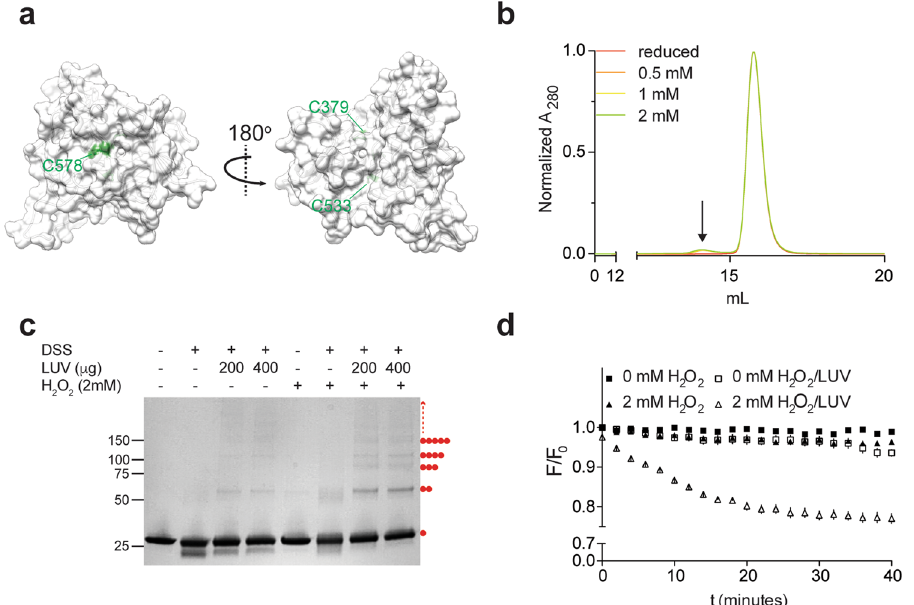
Figure 7. mCLIC6 oligomerization and membrane association. ( a ) Cysteine exposure (green), demonstrated using surface representation of mCLIC6 structure (grey). Note the C533 is inaccessible to the external solution. ( b ) Analytical size exclusion chromatography in the presence of increasing H 2 O 2 concentrations. ( c ) SDS-PAGE of mCLIC6, following DSS-mediated cross-linking in the presence of H 2 O 2 and LUVs. Red circles represent visible oligomeric states of the protein (n = 3). ( d ) mCLIC6 tryptophan fluorescence decay kinetics in the absence or presence of H 2 O 2 and